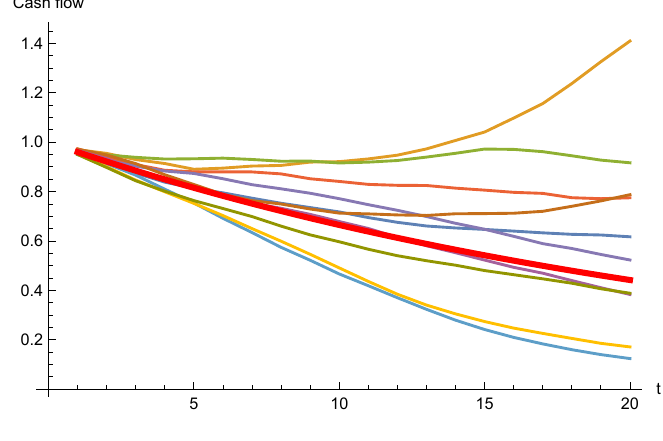
Figure 3. Sticky model: simulated paths of cash flows.